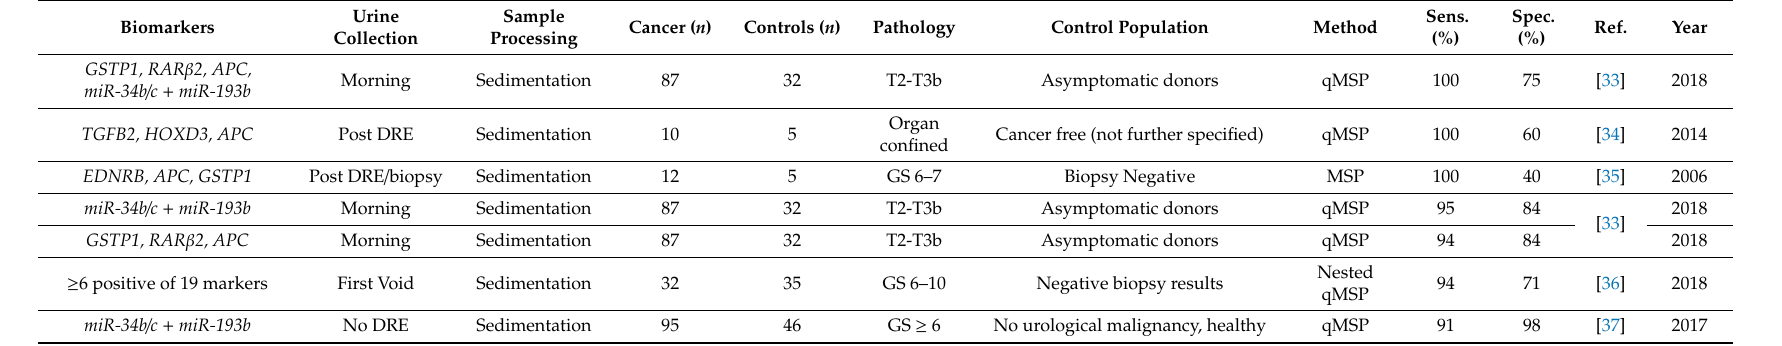
Table 3. DNA-methylation biomarker panels for detection of prostate cancer.